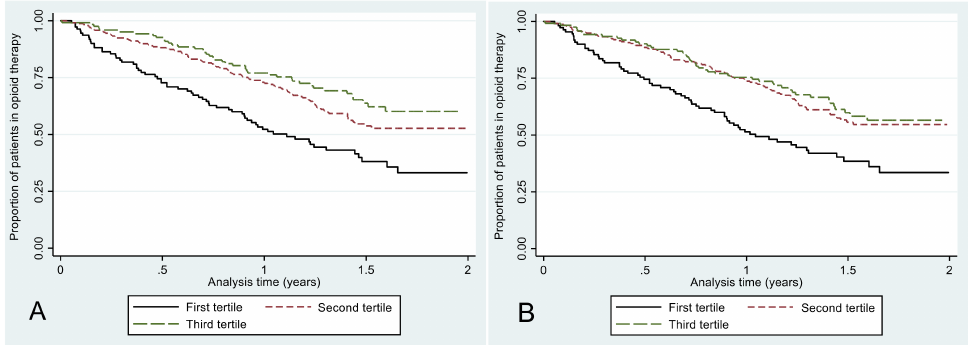
Figure 3. Time to discontinuation of the opioid therapy in the different clusters.